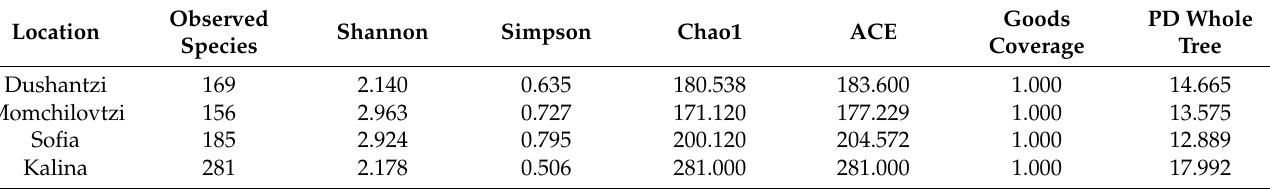
The calculated alpha diversity indexes are presented in Table 5. Table 5. Alpha diversity